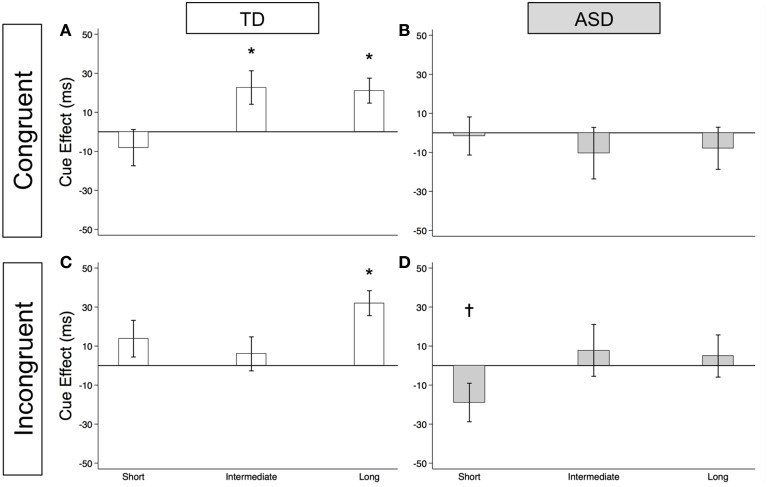
Estimated mean voluntary social orienting cue effects in TD control and ASD children. Estimated mean voluntary cue effects in TD controls (first column; A,C) and subjects with ASD (second column; B,D) in congruent (top row; A,B) and incongruent (bottom row; C,D) trials. A star indicates a significant cue effect (*p < 0.05) and a cross indicates a marginally significant cue effect (†p < 0.10). Error bars represent one standard error.